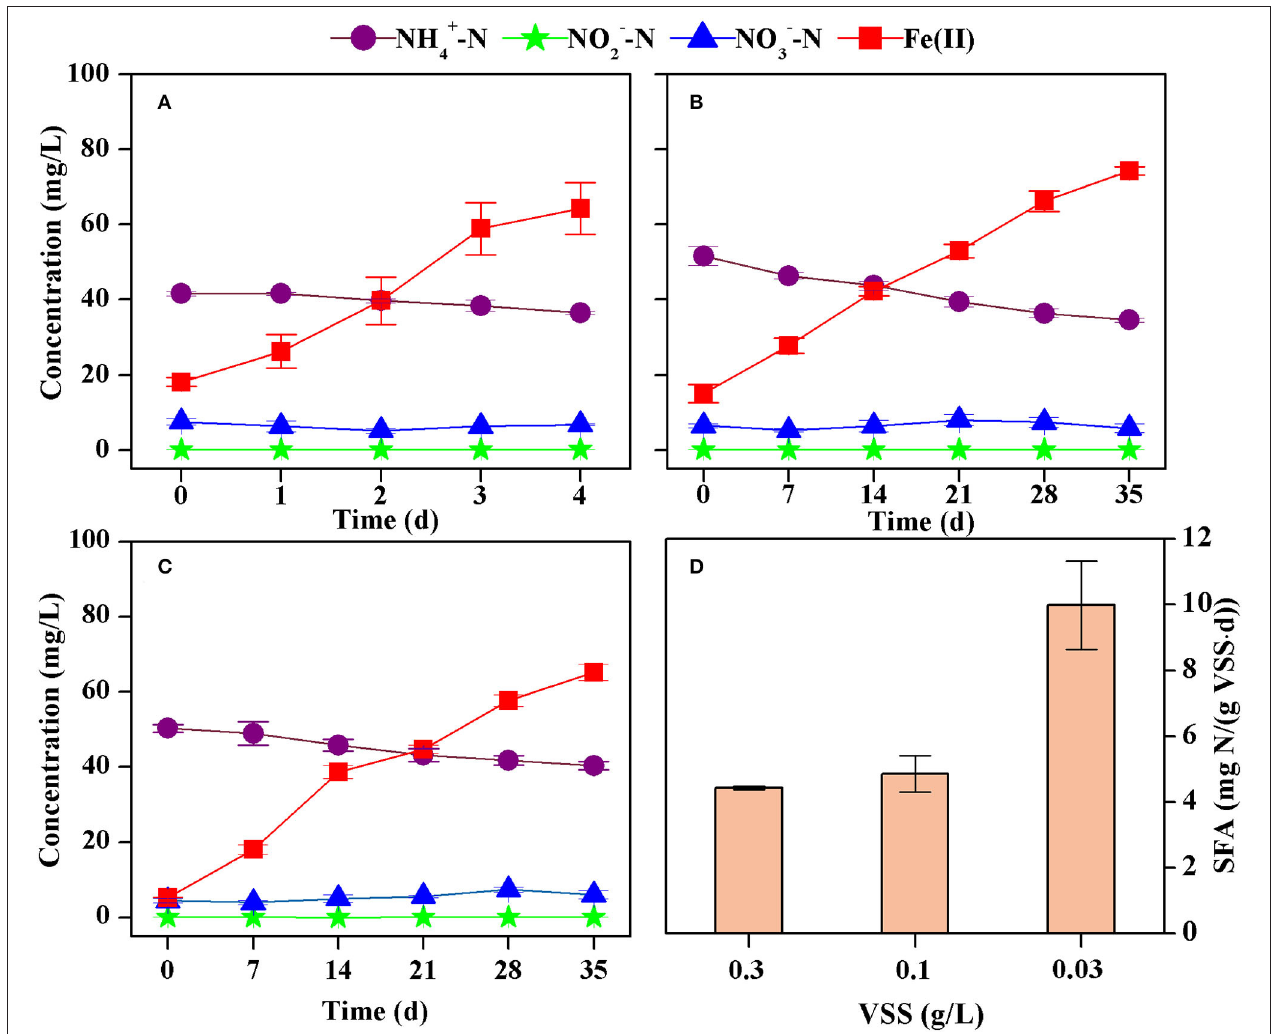
FIGURE 3 | Concentrations of ammonium, nitrite, nitrate, and Fe(II) in batch tests with different VSS concentrations [ (A) 0.30g VSS/L, (B) 0.10g VSS/L, (C) 0.03g VSS/L], and the estimated specific Feammox activity of ammonium oxidation (D)